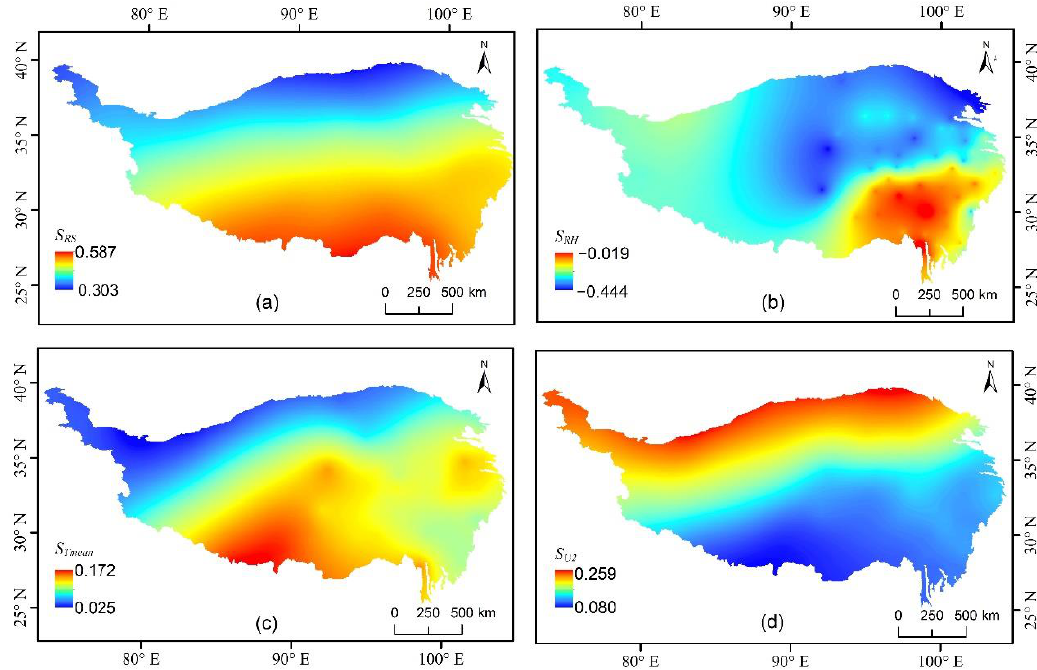
Figure 7. Spatial distribution of sensitivity coefficient on the TP during 1970–2018. ( a ) S RS ; ( b ) S RH .; ( c ) S Tmean ; ( b ) S U 2 .